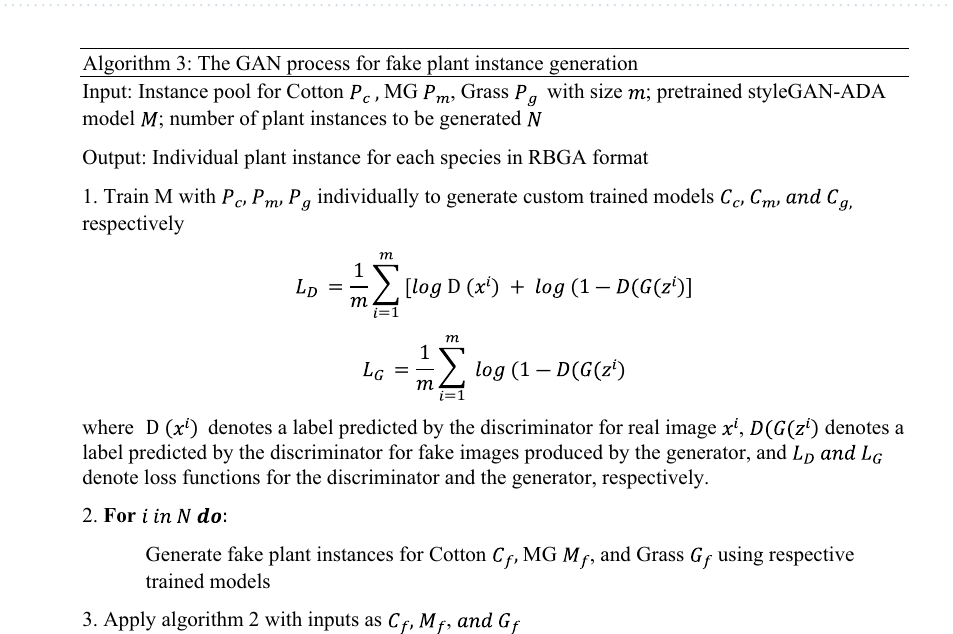
Figure 3. ( a ) Schematic showing the general workflow for a simple generative adversarial network (GAN) model, ( b ) Additional post-processing step for generating new fake plant PNGs using the custom trained styleGAN model, and ( c ) sample results obtained with the custom styleGAN model at various stages of the training process. The faces shown in first sub-figure are fake and do not exist, and are provided by styleGAN-ada repository. The styleGAN-ada script used this fake face template for training initation during the model training